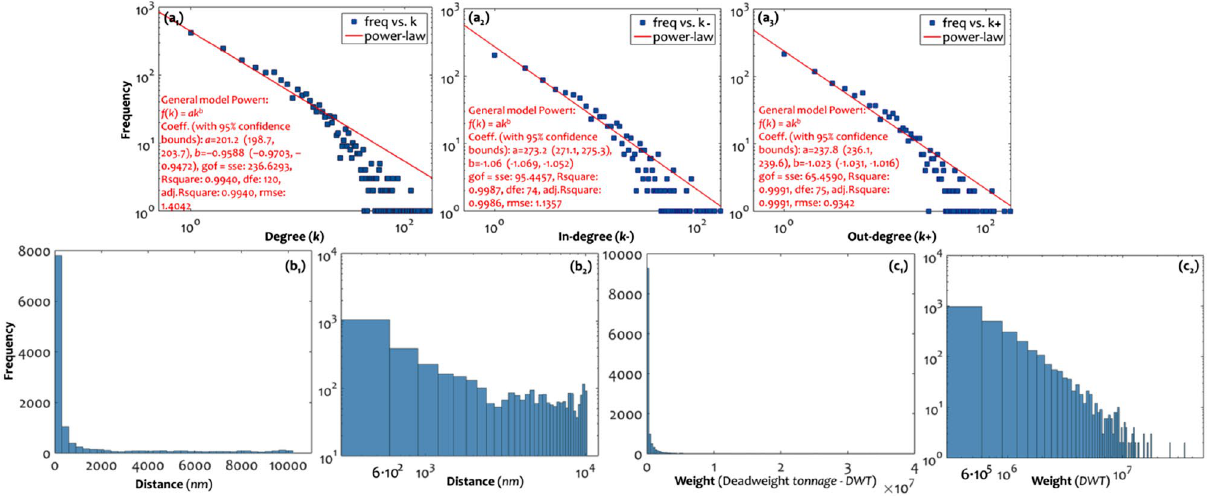
Figure 2. ( a 1 ) Degree ( k , n ( k )), ( a 2 ) In-degree ( k –, n ( k –)), and ( a 3 ) In-degree ( k + , n ( k +)) distribution, showing the edge (distance-weighted, measured in nautical miles—nm) distribution at ( b 1 ) metric and ( b 2 ) log scale, and histograms showing the edge (mass-weighted, measured in deadweight tonnage—DWT) distribution at ( c 1 ) metric and ( c 2 ) log scale, of the original layer ( G o ) of the